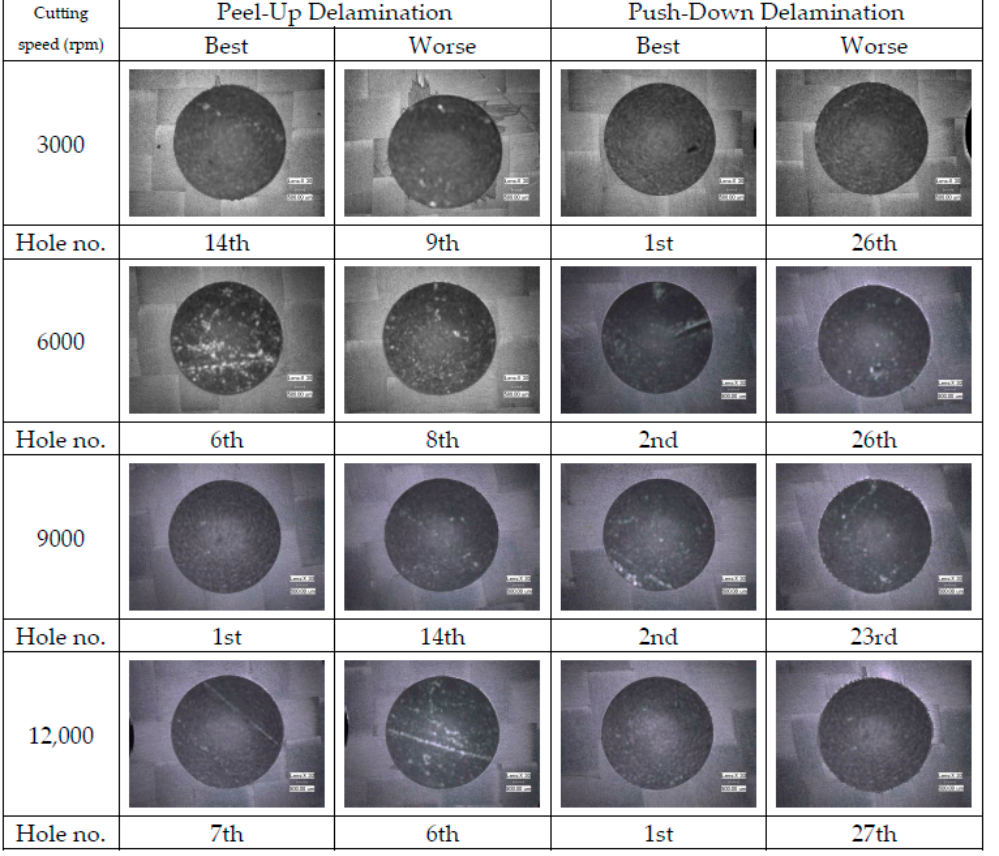
Figure 6. Drilling induced peel-up and push-down delamination with varying cutting speed at feed rate of 400 mm/min.